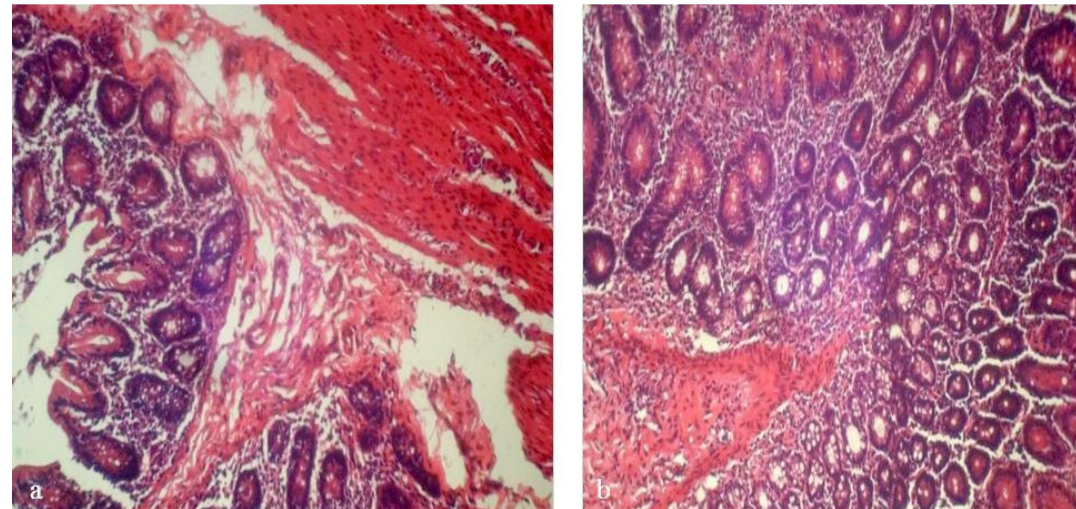
Fig. 4. Induced and treated with 70 mg kg -1 extract. The Photomicrograph shows marked muscle hyperplasia and infiltration with neutrophils; a) Mag. X 200. The mucosa shows mild hyperplasia and is lined by tall cuboidal epithelial cells; b) Mag. X 200